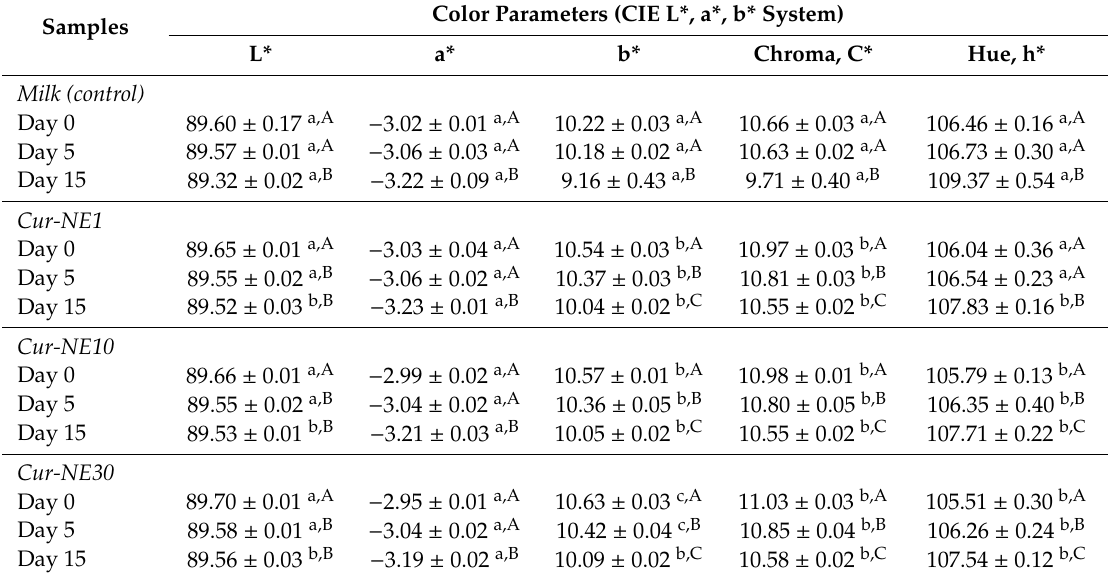
Table 5. Color parameters of the milk with fortified curcumin